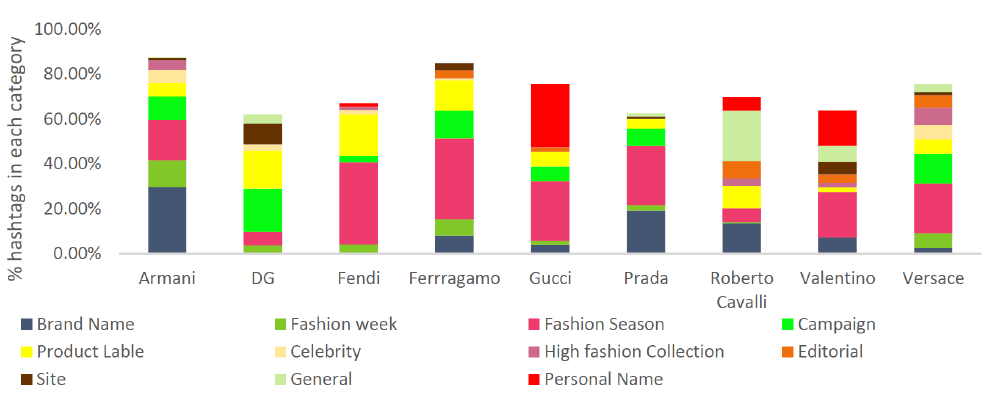
Figure 10. The most persuasive hashtag categories by brands, based on frequency of appearance.